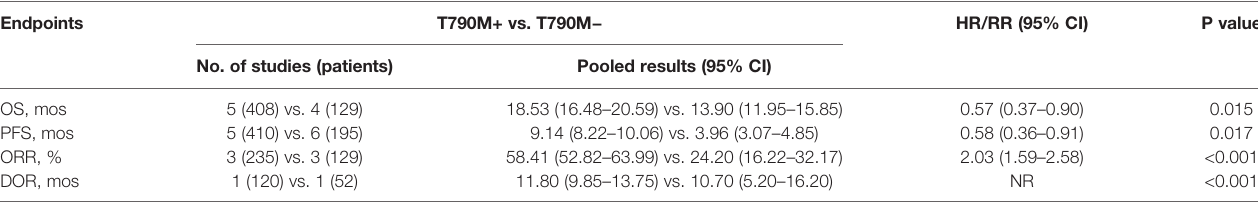
TABLE 2 | Pooled results of survival and response rate for the different T790M mutational statuses. Endpoints